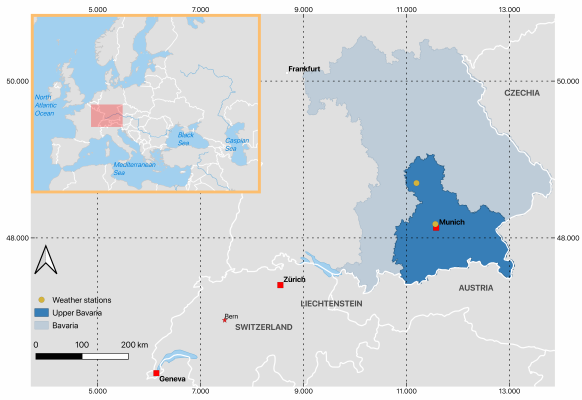
Figure 1. Experimental site in WGS84 (EPSG:4326). All crop type samples were randomly selected in the region of Upper Bavaria. Two weather stations (in orange) were used to generate the climatological overview.